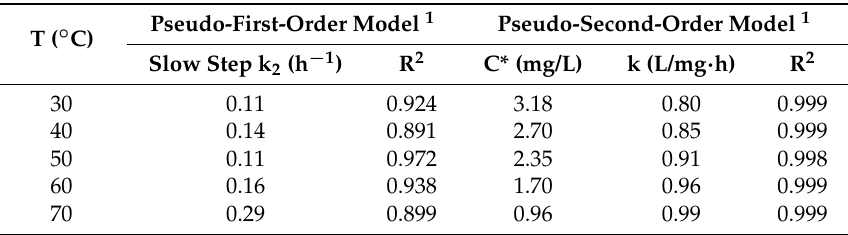
Table 7. Kinetics parameters for the degradation of NAP at different temperatures for pseudo-first-order and pseudo-second-order